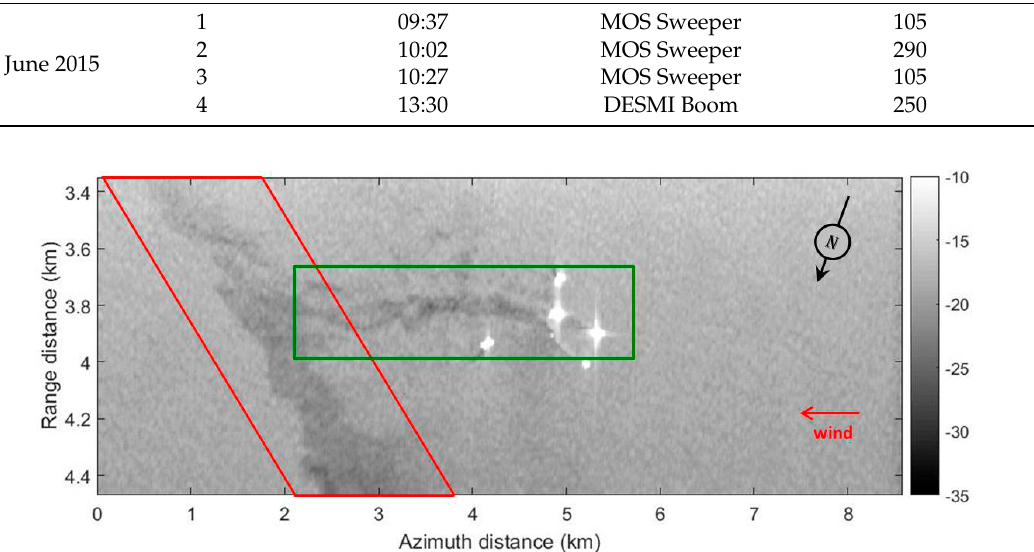
Figure 5. SETHI L-band SAR data, VV-polarization, 13:30 UTC. Red box: MOS Sweeper spill. Green box: DESMI Boom spill—multi-look 21 × 21.